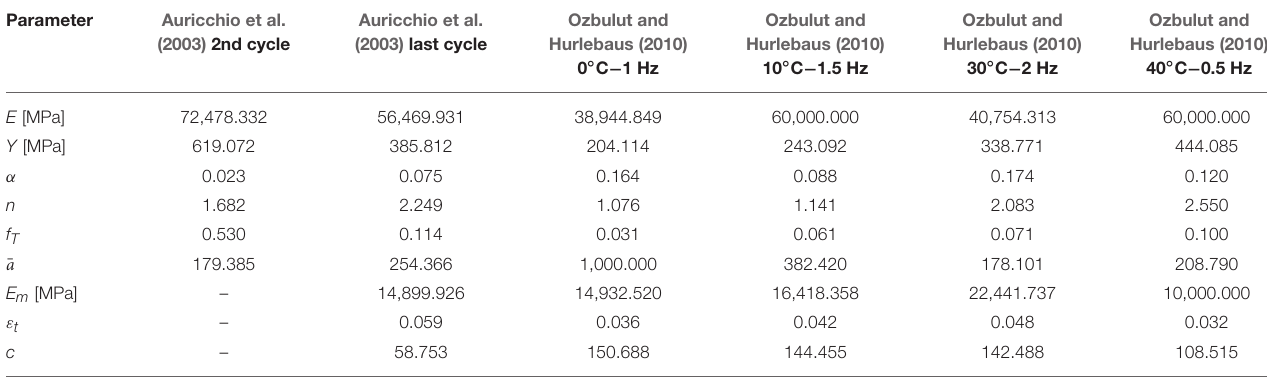
TABLE 5 | Identified parameters of the proposed model for the experimental data shown in Figures 5E,F . Parameter Auricchio et al. (2003) 2nd cycle